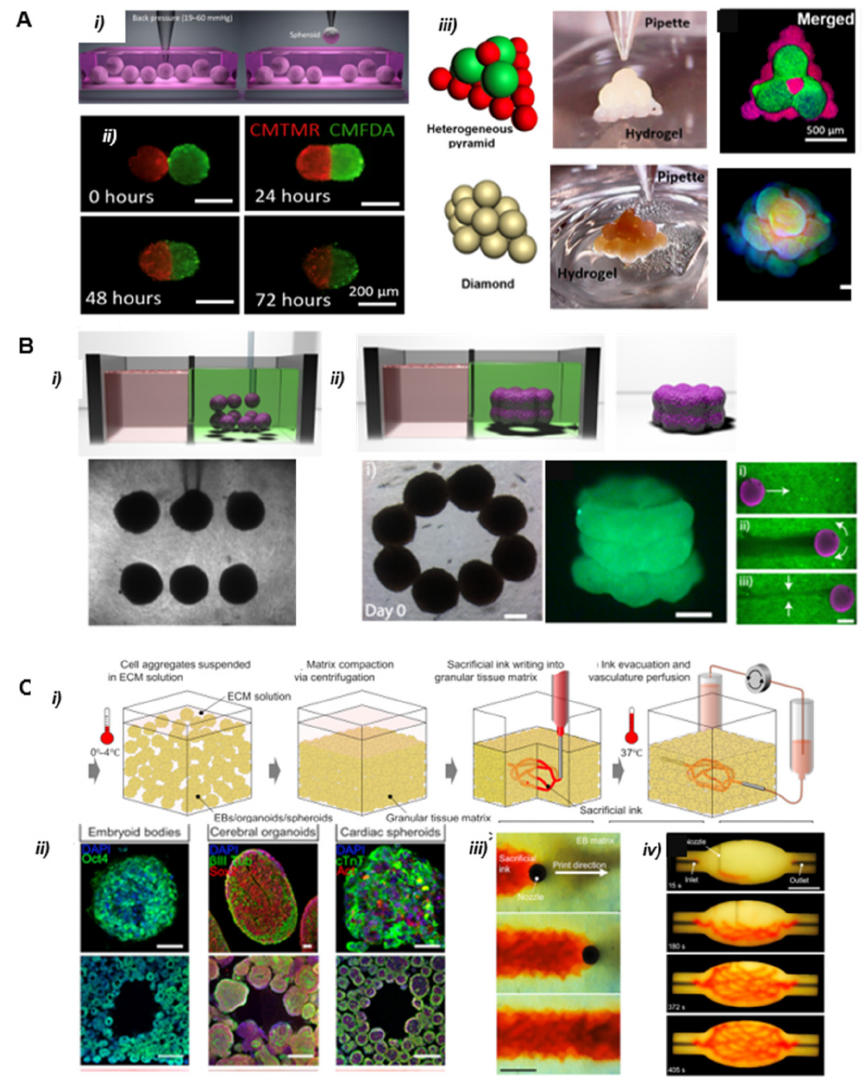
Figure 8. ( A ) Bioprinting of spheroids by a pressure-driven method Reprinted from Ref.